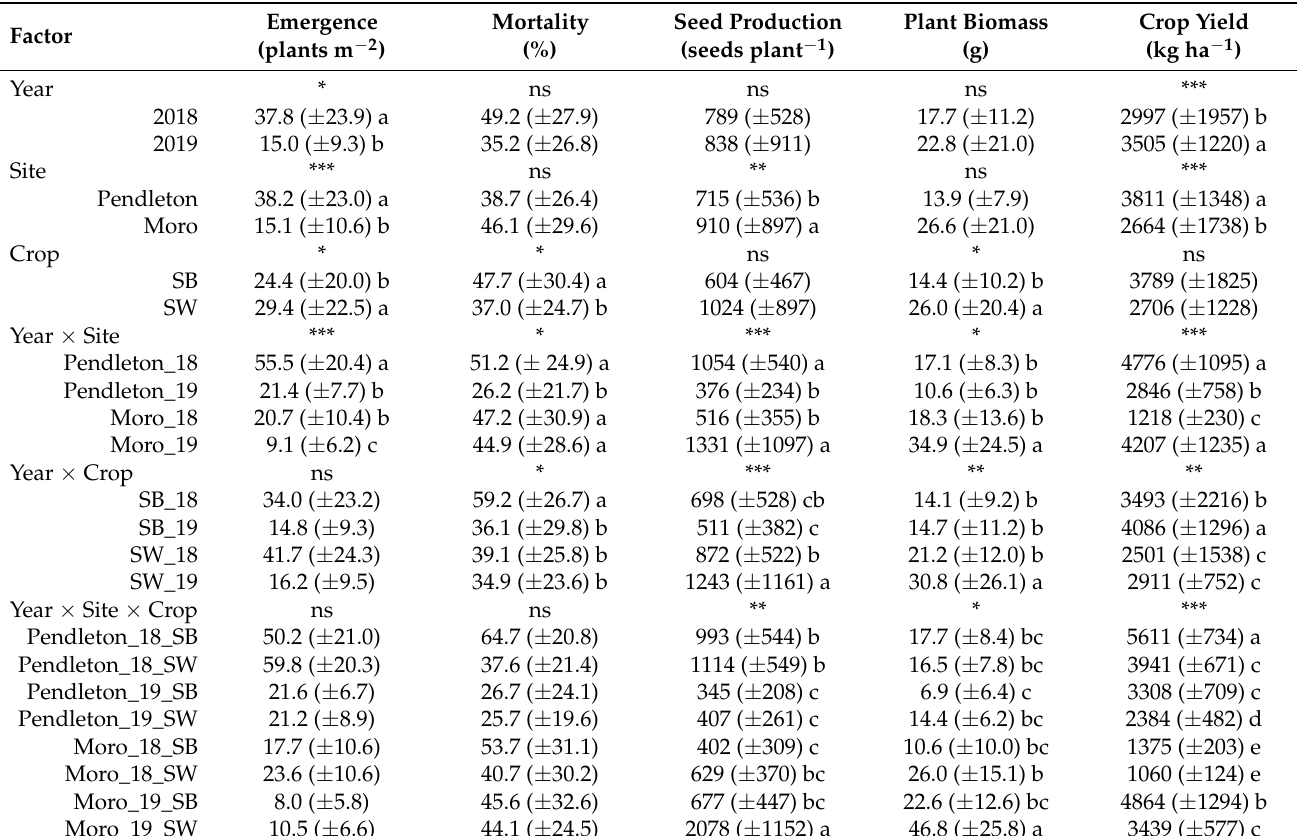
Table 1. Effect of year, site, crop, and their interactions on Russian thistle emergence, mortality, seed production, plant biomass, and crop yield (mean ± standard deviation). All means were compared with Tukey’s